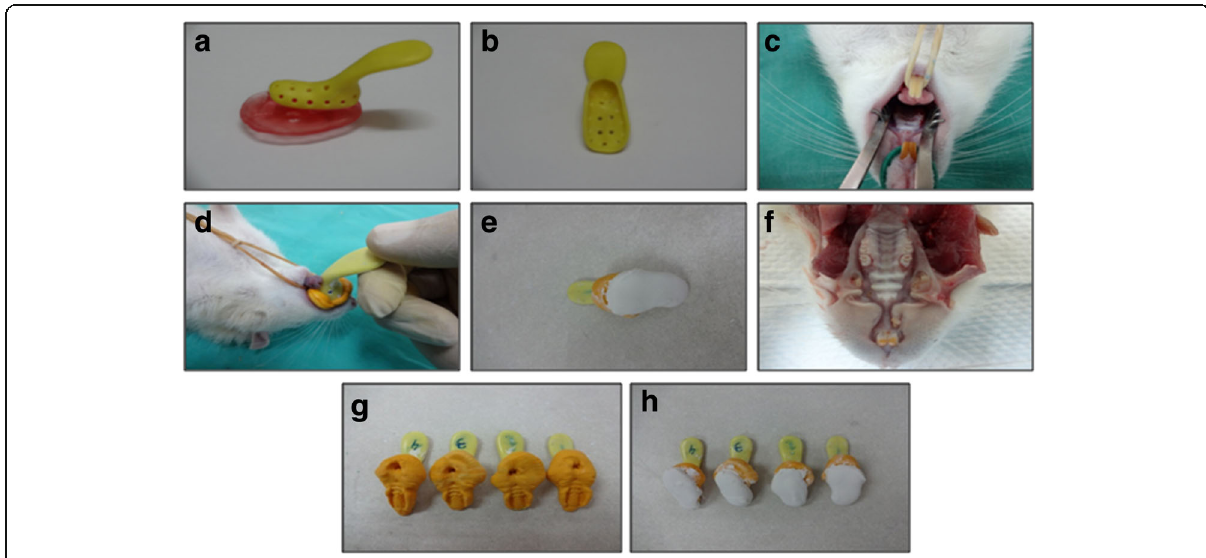
Fig. 2 Rats impressions and study models formation. a fabrication of impression tries, b impression tray ready to be used, c rat in the position for taking impression, d taking first impression, e making first study model, f rat maxilla after animal sacrificed and orthodontic appliance was